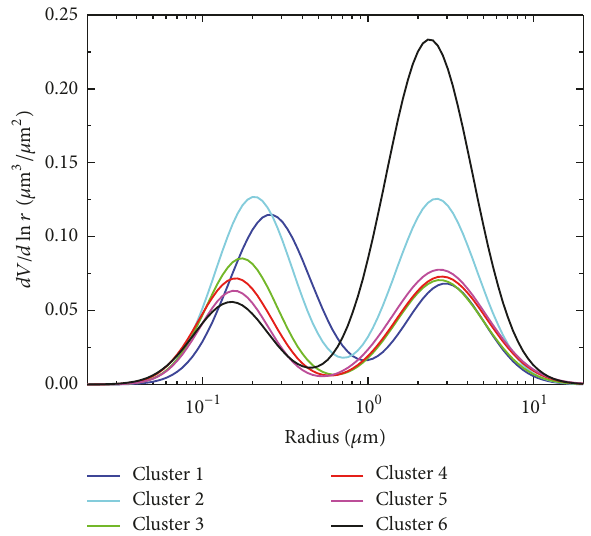
Figure 3: The particle size distributions of six cluster